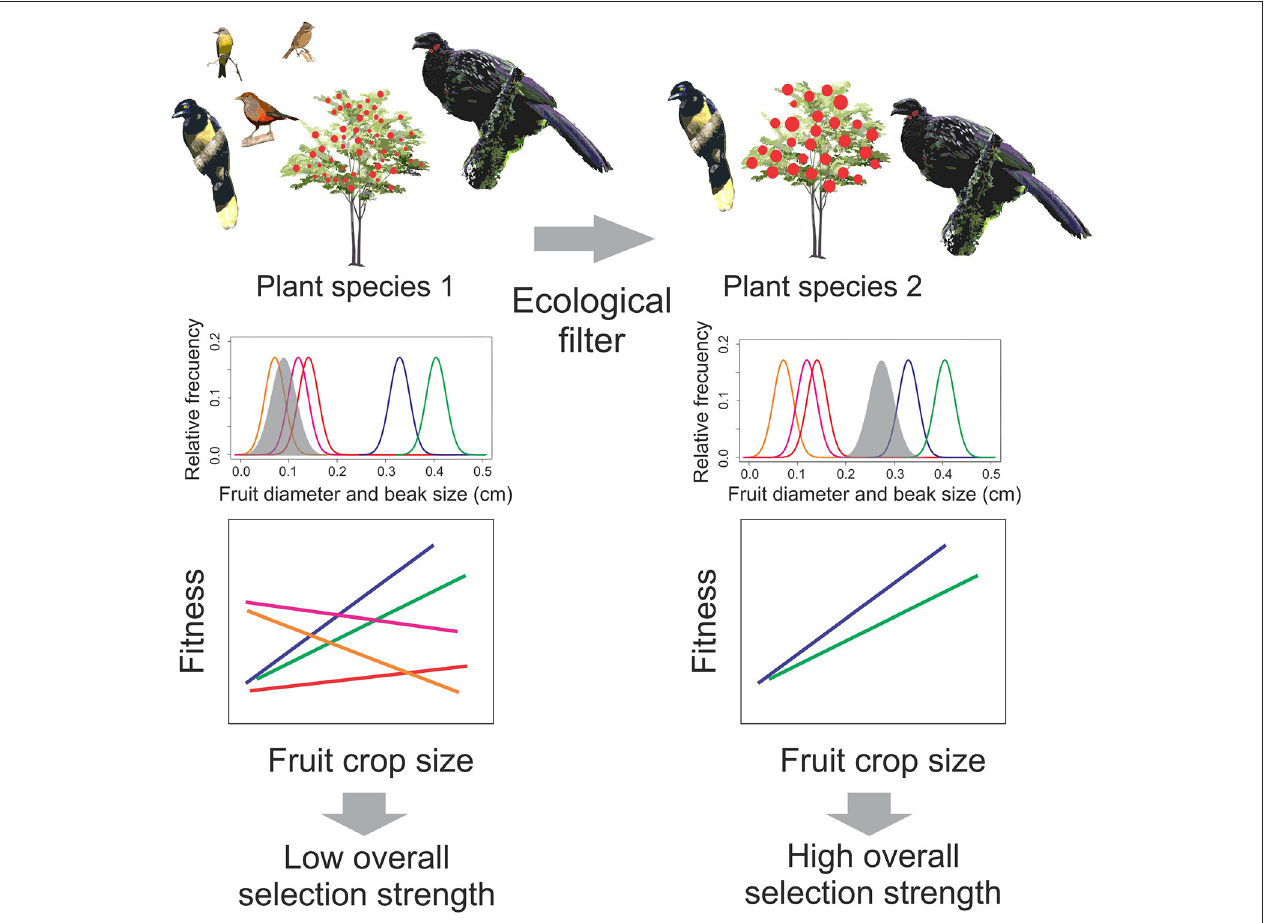
FIGURE 1 | Functional equivalence hypothesis and bird-mediated selection strength on fruit crop size. Ecological filters promoting high functional equivalence would translate into similar selection pressures on fruit display traits increasing selection strength on fruit crop size. As an example, suppose a plant species interacts with an assemblage of frugivorous birds. This plant produces fruits with an average size that may be swallowed by most frugivores from the assemblage, reflected by the frequency distributions of beak sizes (colored lines) and fruit diameter (shaded areas). Under this scenario, birds exert different selection pressures on fruit crop size, some of which may be even conflicting. The expected outcome is a dilution of all selection regimes, resulting in a low overall (assemblage level) selection strength on fruit crop size. When the same frugivore assemblage interacts with another plant species of a larger mean fruit size, some species (small frugivores) are forbidden to interact with the plant due to fruit size constraints (ecological filter), leaving a subset of species playing similar roles for the interaction (large frugivores). Under this scenario, birds are expected to select similar fruit traits and exert similar selection regimes on fruit crop size, thus leading to high overall selection strength. Other ecological filters proposed in this study are fruit type, length of the fruiting season, proportion of gulper and seed predator species, and latitude (see Table 1 ). Artwork: F. X.